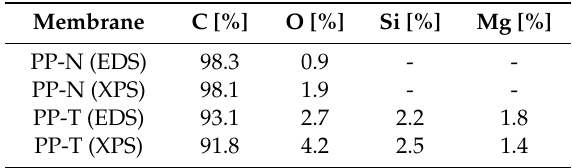
Figure 11. Results of XPS analysis surface of membrane samples (feed side) after 350 h of MD process duration. Table 6. The results of EDS and XPS analysis of membrane samples.